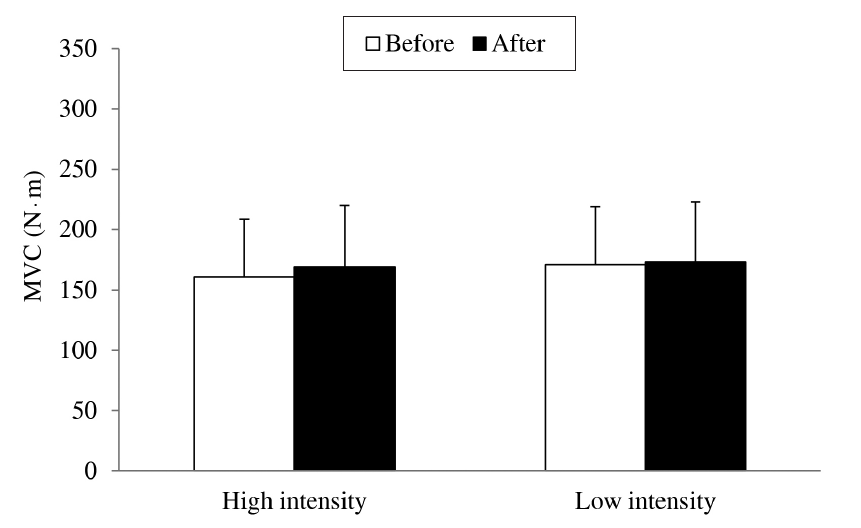
Figure 1. Girls’ MVC test re